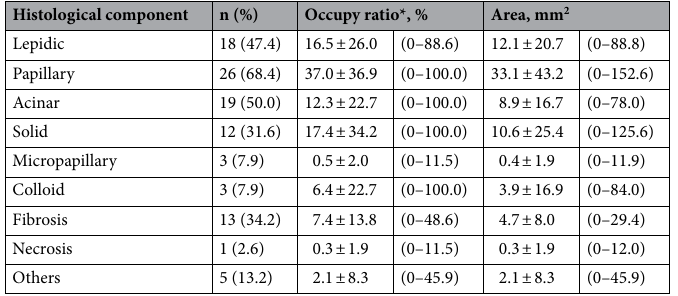
predominant lesions (median, − 88 ± 109 HU; p = 0.039). Figure 2B shows maximum CT values of lepidic and non-lepidic predominant lesions. The maximum CT value was significantly lower in lepidic predominant lesions (median, 263 ± 53 HU) than in non-lepidic predominant lesions (median, 348 ± 91 HU; p = 0.015). As shown in Fig. 2C, the optimal threshold mean CT value for lepidic predominant lesions was − 150 HU (area under the ROC curve, 0.739; 95% CI, 0.55–0.92), with a sensitivity of 77.8% and a specificity of 82.8%. Figure 2D shows that the optimal threshold maximum CT value for lepidic predominant lesions was 320 HU (area under the ROC curve, 0.770; 95% CI, 0.59–0.95), with a sensitivity of 77.8% and a specificity of 72.4%.